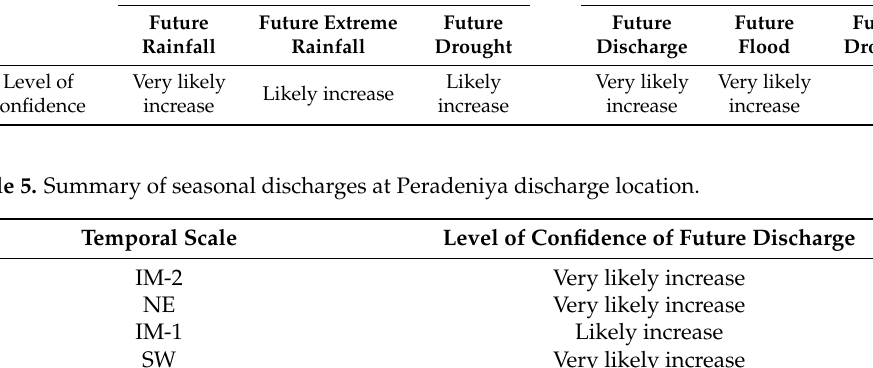
Table 5. Summary of seasonal discharges at Peradeniya discharge location.